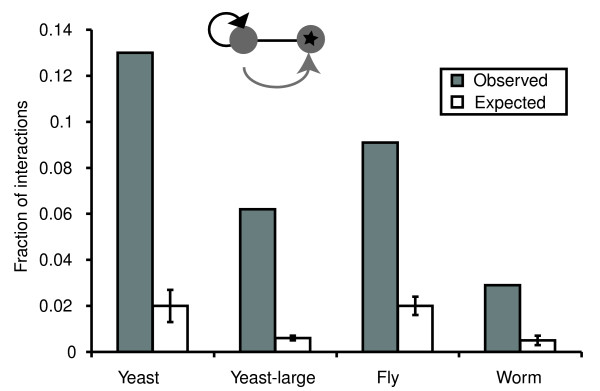
Dimers of paralogues in the protein-protein interaction network. On top is a cartoon illustrating how paralogous dimers result from the duplication of proteins that form homodimers. The bar chart shows the fraction of paralogous dimers (gray bars) in four protein interaction networks compared with random expectation levels, obtained by 10,000 network randomizations by shuffling evolutionary relationships (p < 10-4; see Materials and methods for details).